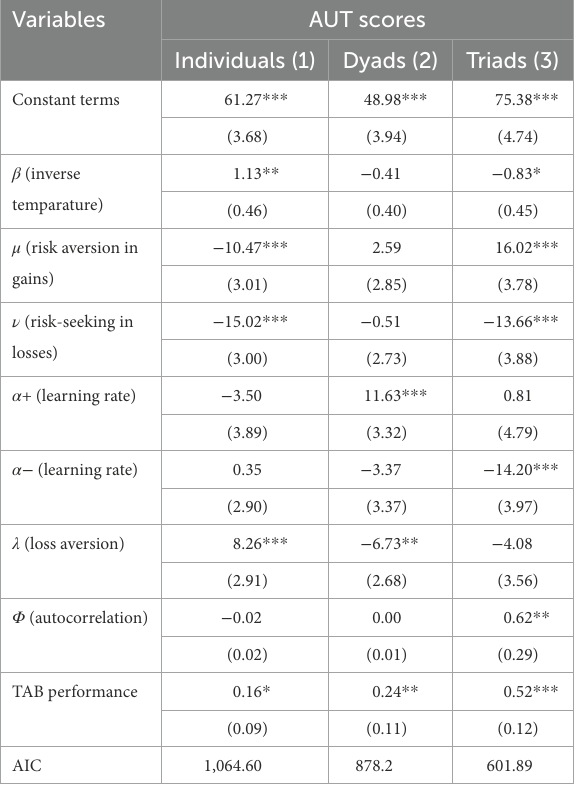
TABLE 2 Poisson regression results (SE in